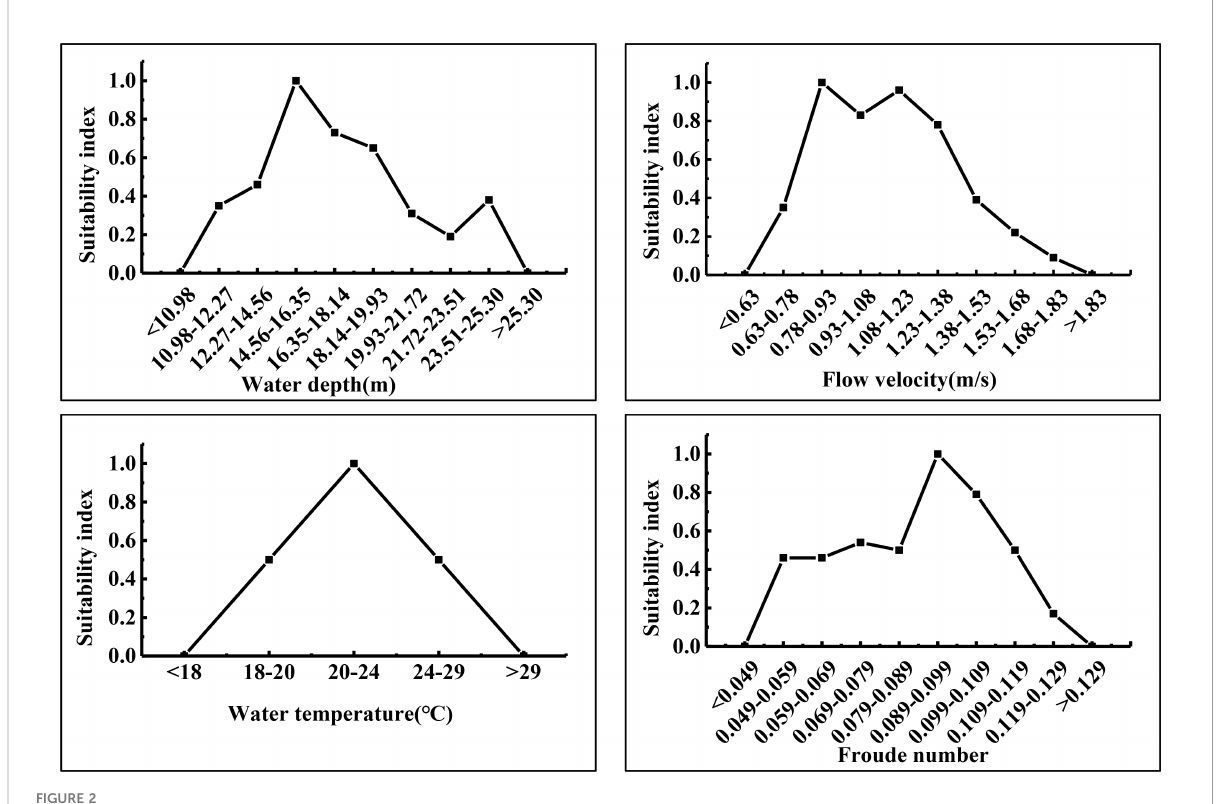
FIGURE 2 Suitability curves during Asian carp spawning